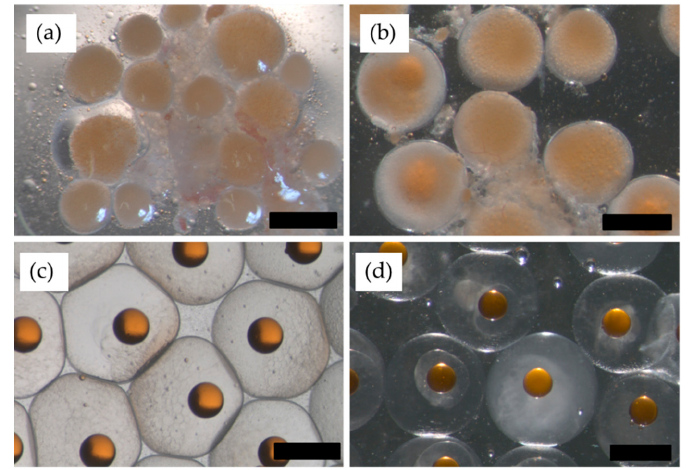
Figure 1. Progression of ovarian development in a first filial (F1) h ā puku ( Polyprion oxygeneios ) administered a 1 mg GnRHa implant in October 2013 (target dose of 100 µ g / kg − 1 of body weight; achieved dose 118 µ g / kg − 1 ), followed three weeks later by two consecutive intramuscular injections of GnRHa (dose: 30 µ g / kg − 1 ) 24 h apart. ( a ) Ovarian biopsy containing late vitellogenic oocytes